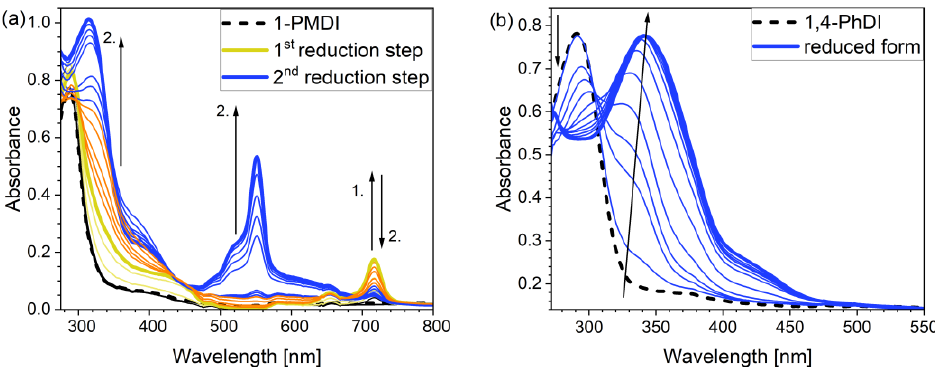
Figure 4. UV–Vis spectra of 1-PMDI ( a ) and 1,4-PhDI ( b ) collected for decreasing working electrode potential in 0.1 M Bu 4 NPF 6 /DMF electrolyte.